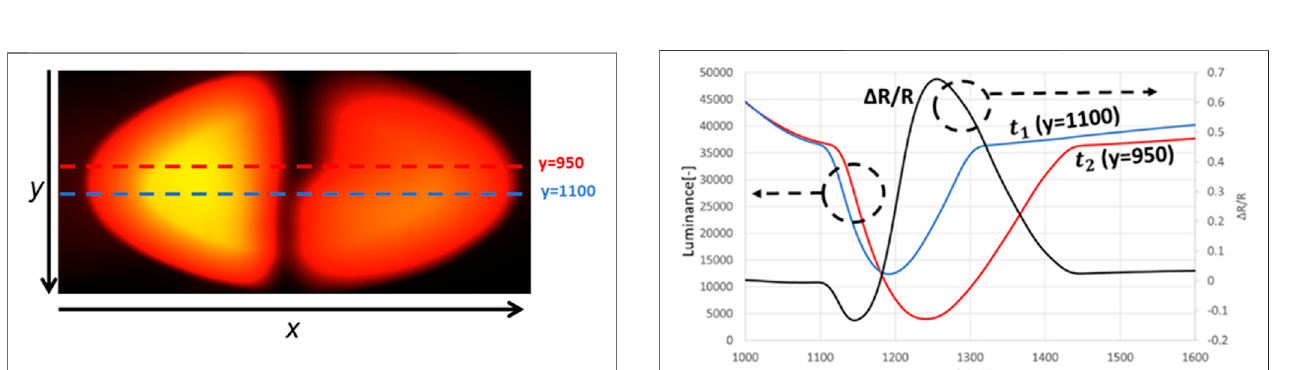
FIGURE 4 | The luminance distribution from the wedge-shaped Au thin fi lm (II) in air.